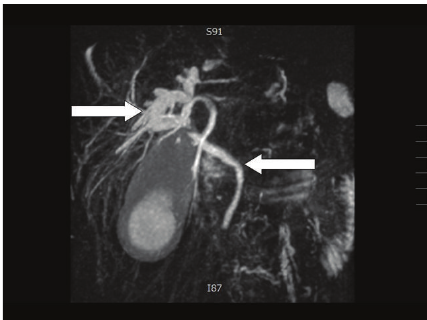
Figure 2: Dilatation of the intrahepatic bile ducts with a normal choledochus (personal observation).